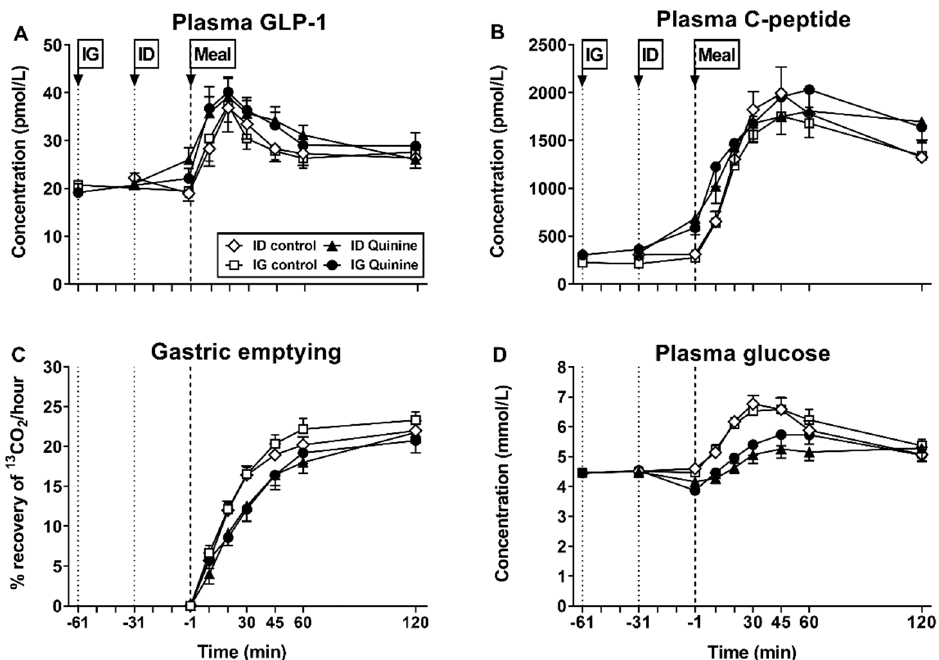
Figure 1. Effects of quinine on ( A ) plasma glucagon-like peptide-1 (GLP-1), ( B ) plasma C-peptide, ( C ) gastric emptying (measured using a 13 C-acetate breath test) and ( D ) plasma glucose in 14 healthy men. Quinine, given as quinine hydrochloride in a dose of 600 mg, or control, was administered either intragastrically (IG, at t = − 61 min), or intraduodenally (ID, at t = − 31 min), before a mixed-nutrient drink (500 kcal, 74 g carbohydrates), consumed at t = − 1 min. IG and ID administration of quinine comparably ( A ) increased plasma GLP-1 concentration before, and in response to, the drink, ( B ) increased plasma C-peptide, before, and during the first 10 min in response to, the drink, ( C ) slowed gastric emptying of the drink, and ( D ) reduced plasma glucose before, and particularly following, the drink (Reprinted with permission from ref. [20]. Copyright 2021 Oxford University Press).